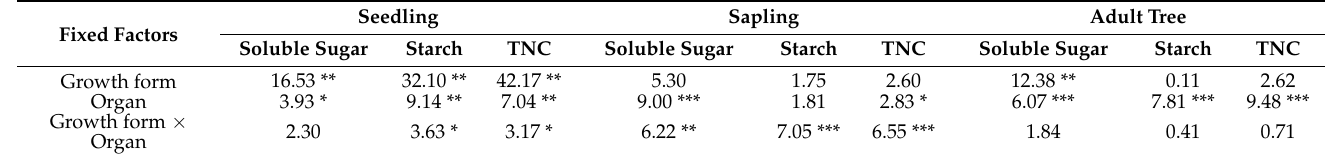
Table 4. Results for mixed linear models of NSC storage between different life stages. In each life stage, the NSC concentration was used as the dependent variable, growth forms, organs. Their interactions were used as fixed factors, and different individuals were used as random